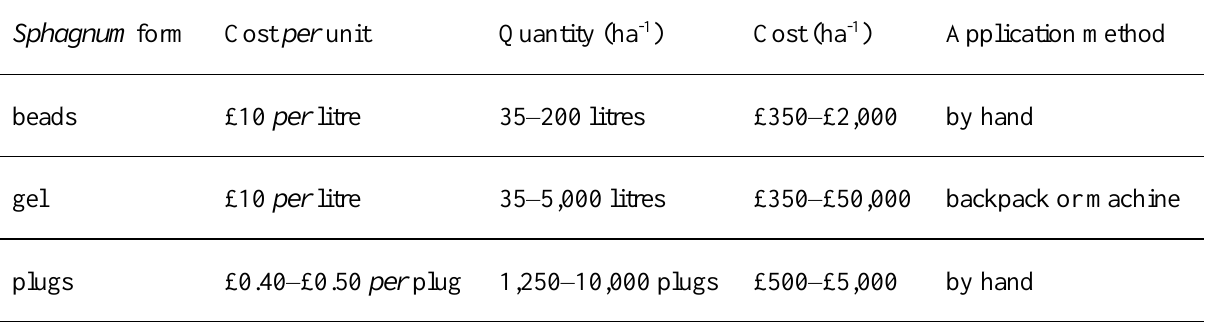
Table 4. Indicative costs (in GBP/pounds sterling) of micropropagated Sphagnum materials in 2018 and their usual methods of application (Micropropagation Services